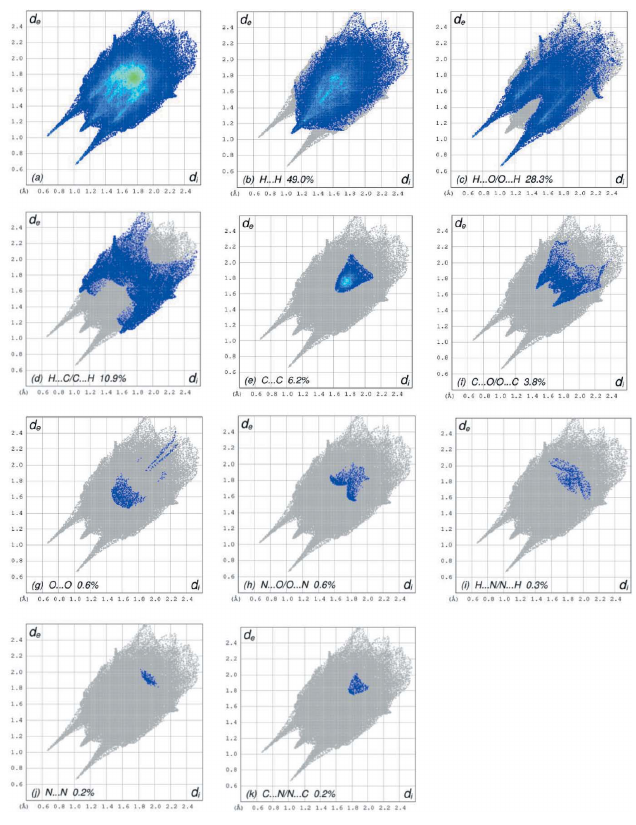
Figure 6 The full two-dimensional fingerprint plots for the title compound, showing ( a ) all interactions, and delineated into ( b ) H (cid:2)(cid:2)(cid:2) H, ( c ) H (cid:2)(cid:2)(cid:2) O/ O (cid:2)(cid:2)(cid:2) H, ( d ) H (cid:2)(cid:2)(cid:2) C/C (cid:2)(cid:2)(cid:2) H, ( e ) C (cid:2)(cid:2)(cid:2) C, ( f ) C (cid:2)(cid:2)(cid:2) O/O (cid:2)(cid:2)(cid:2) C, ( g ) O (cid:2)(cid:2)(cid:2) O, ( h ) N (cid:2)(cid:2)(cid:2) O/O (cid:2)(cid:2)(cid:2) N, ( i ) H (cid:2)(cid:2)(cid:2) N/N (cid:2)(cid:2)(cid:2) H, ( j ) N (cid:2)(cid:2)(cid:2) N and ( k ) C (cid:2)(cid:2)(cid:2) N/N (cid:2)(cid:2)(cid:2) C inter- actions. The d i and d e values are the closest internal and external distances (in A˚ ) from given points on the Hirshfeld